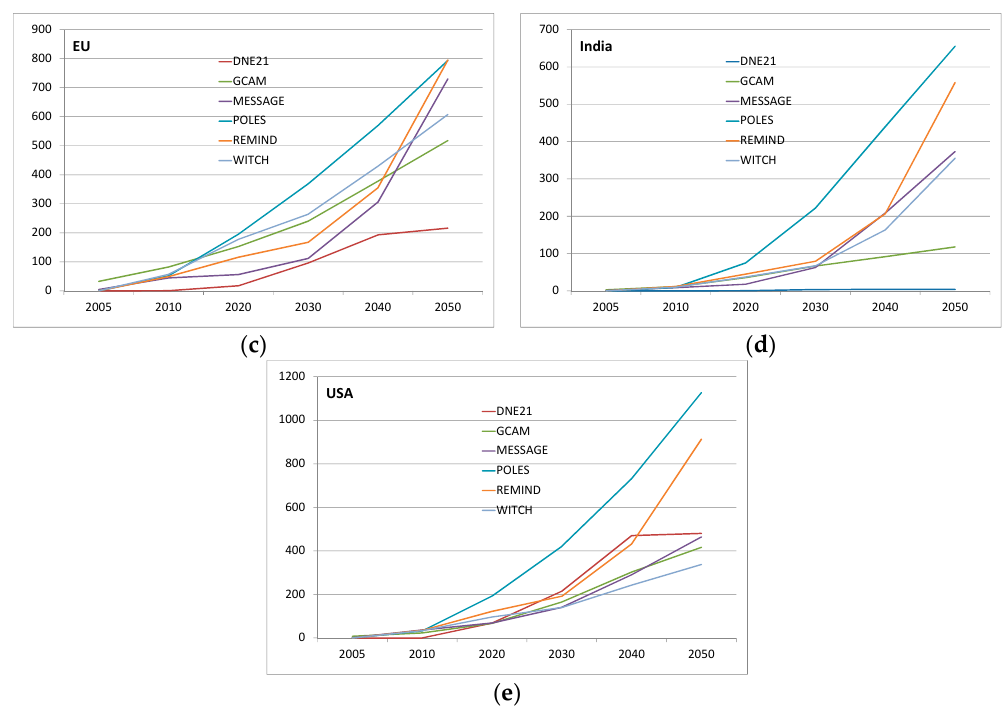
Figure B3. Inter-model comparison of installed capacity (GW) for wind (offshore and onshore) in ( a ) World (2030–2050 growth rate = 5%–10% p.a.); ( b ) China (2030–2050 growth rate = 5%–13% p.a.); ( c )